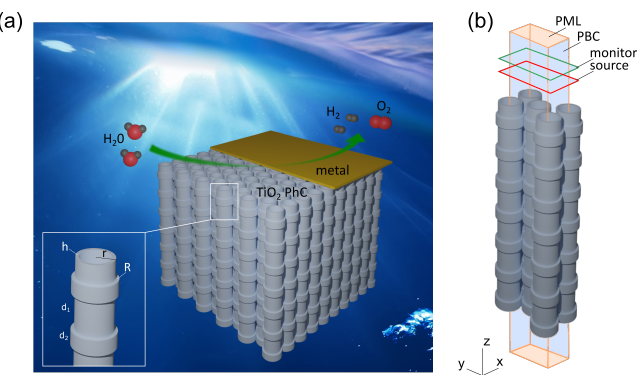
Figure 1. ( a ) Sketch view of the titanium oxide nanotubes arranged in hexagonal array for photocat- alytic water splitting. Tamm plasmon polariton (TPP) transforms the light energy under the metal film for frequencies in stop-band of photonic crystal (PC). PC parameters are defined in the inset and specified in Table 1. ( b ) Finite difference time domain simulation box, the upper side is set to perfectly matched layer (PML), the vertical side is set to periodic boundary conditions (PBC), the monitor of reflected field is places above the radiation source.